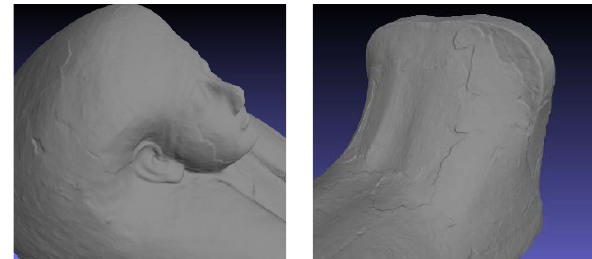
Figure 11. Bar calibration.